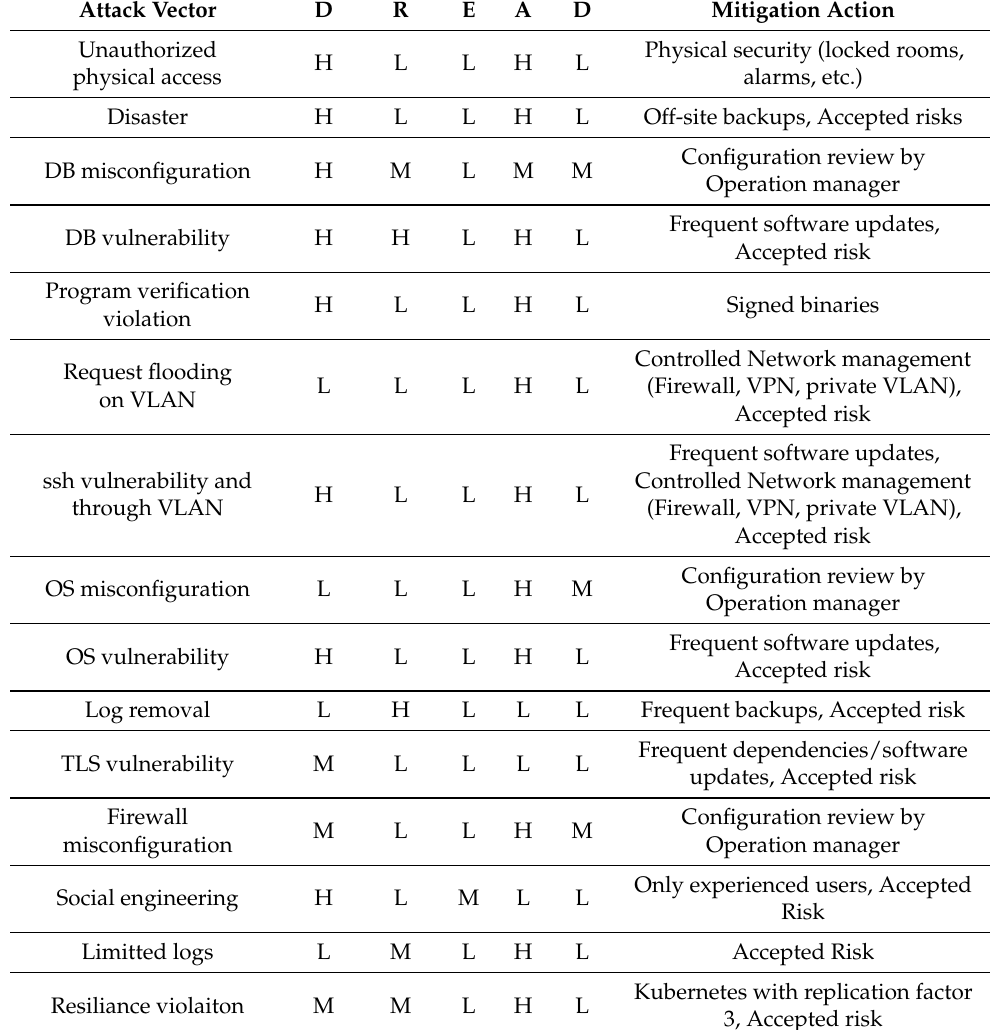
Table 2. DREAD Classification for each Identified cybersecurity